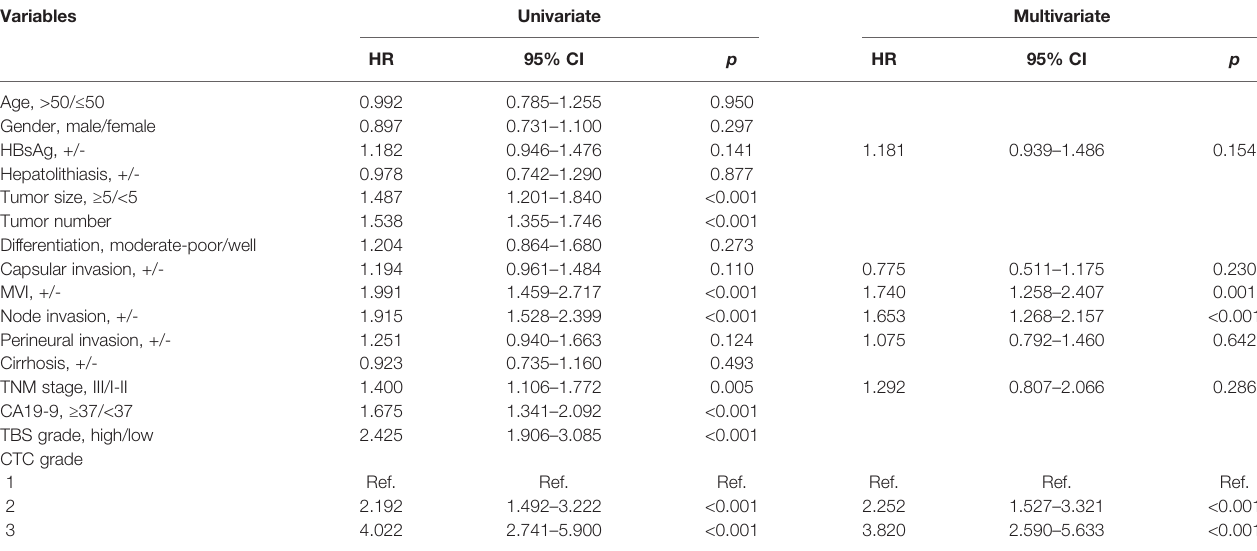
TABLE 4 | Cox regression analysis for RFS of ICC patients in the derivation cohort.